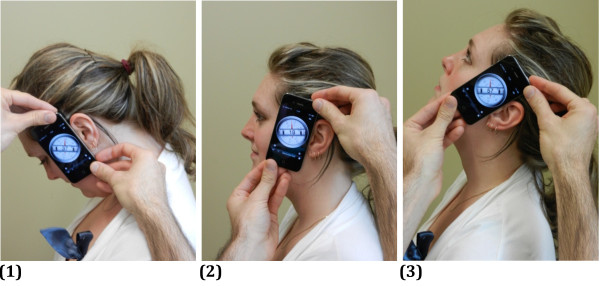
Position of the iPhone for the measurement of flexion and extension. (1) Position at end range of flexion. (2) Starting position. (3) Position at end range of extension. The side of the iPhone is aligned with the ear insertion to the head.